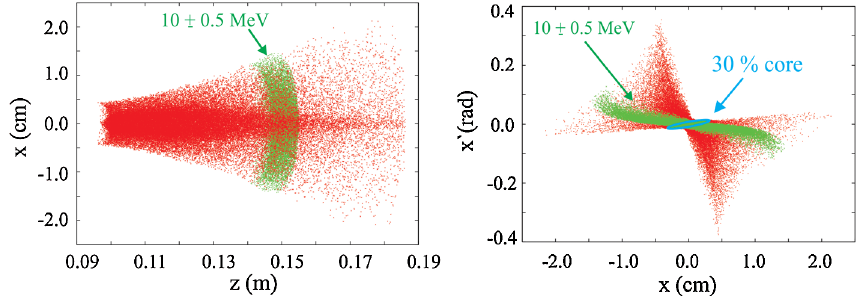
FIG. 17. (Left) z - x proton distribution after the solenoid. The longitudinal position is correlated to the individual proton energies. (Right) x - x 0 distribution for the same propagation time t ¼ 3 : 4 ns . The green marked area corresponds to the energy of interest (see also Fig. 25 for a more detailed